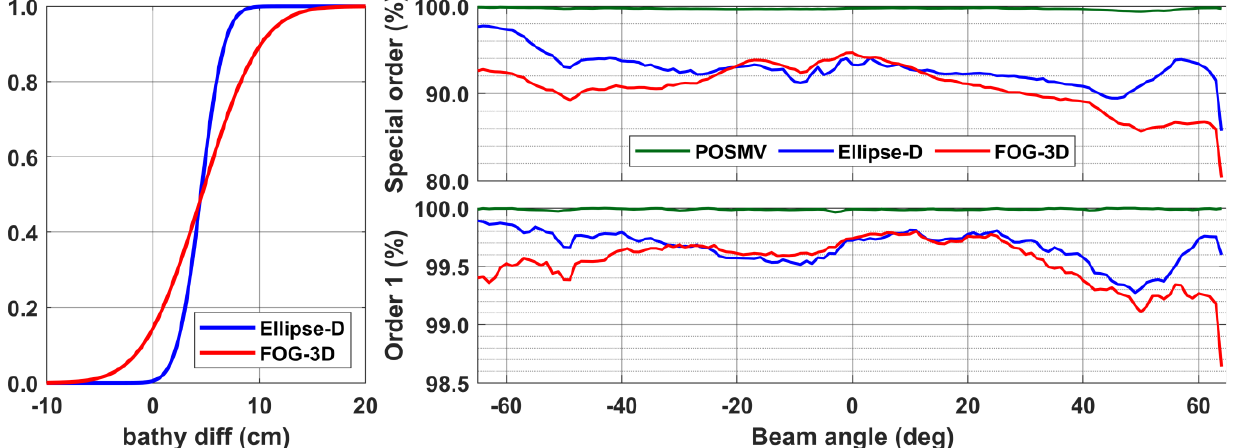
Figure 11. Left panel: Cumulative distribution function describing Ellipse-D and FOG-3D bathymetric surface difference relative to POSMV (Wave-Master). Right panels: percentages of soundings at passing Special ( top ) and Order-1 ( bottom ) at beams between the ± 65° swath.